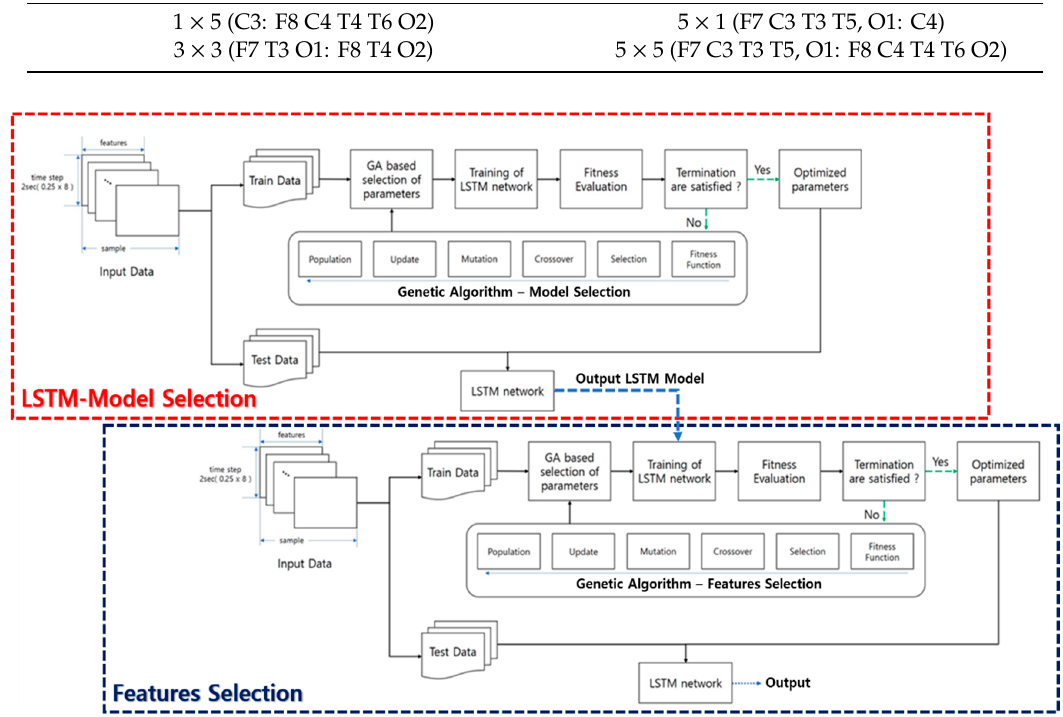
Figure 4. Proposed GA-LSTM model architecture.